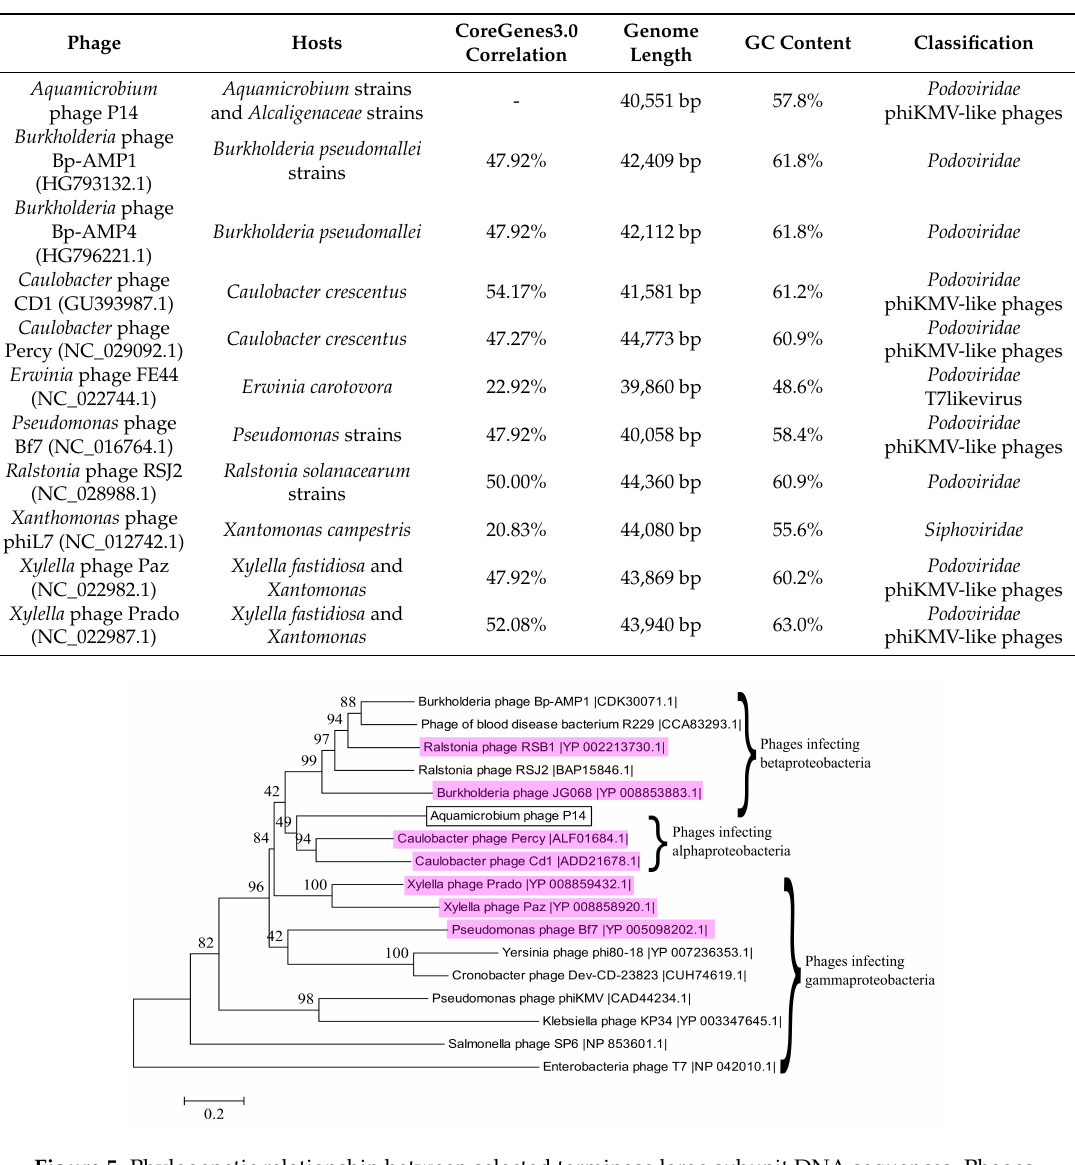
Figure 5. Phylogenetic relationship between selected terminase large subunit DNA sequences. Phages that are classified as phiKMV-like are highlighted in magenta. The best model for the phylogenetic tree construction was found by jmodeltest 2.1.10 [35] to be GTR + G + I. The model was then constructed using Mega6 [36] with 500 bootstrap